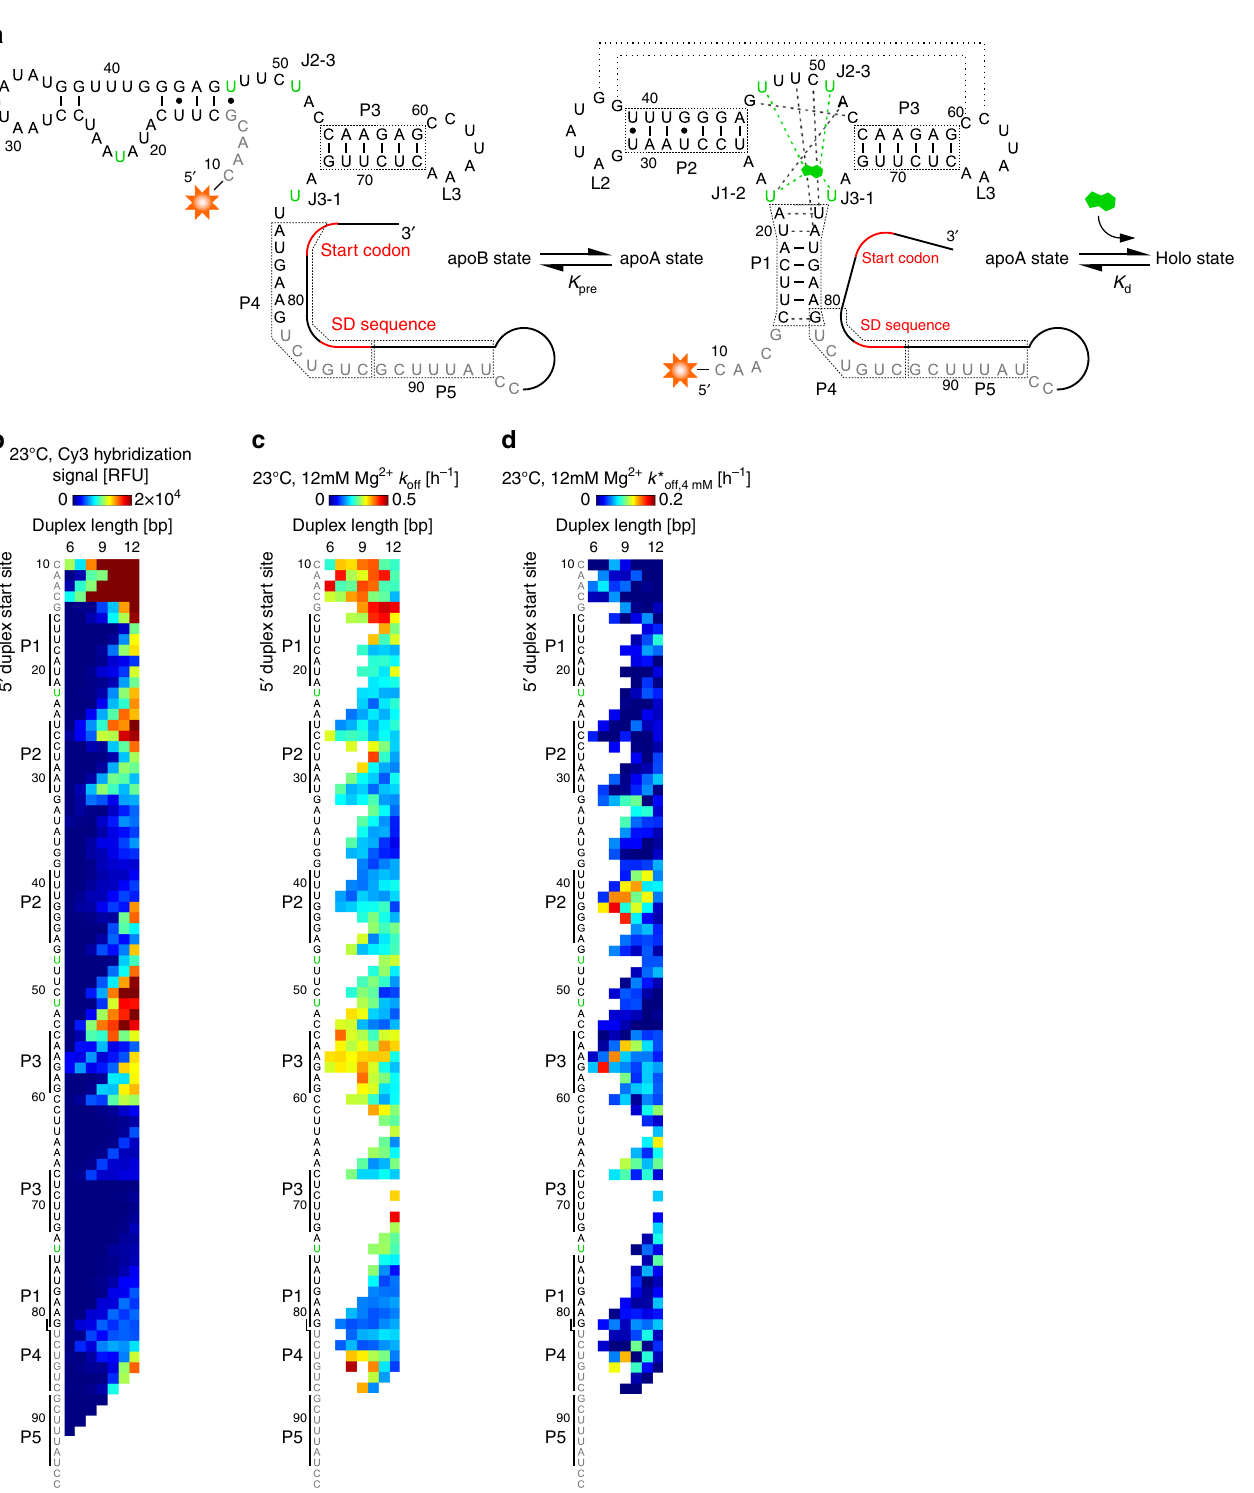
Fig. 6 ACE-Scan of the adenine-binding add riboswitch aptamer. a Secondary structure of the apoB (left) and apoA (right) states of the add riboswitch aptamer 46 . Stems (P1 – P5), loops (L2, L3) and junctions (J1 – 2, J2 – 3, and J3 – 1) are labeled. The location of adenine binding and other functional regions present in the holo structure are shown superimposed on the apoA state as follows: the kissing interaction between L2 and L3 (dotted lines), nucleotides known to interface with adenine (green bases and green dashed lines), and pairs of nucleotides known to interface in the holo state (black dashed lines). Riboswitch elements 3 ʹ of the aptamer involved in translational control were not synthesized here and are drawn schematically as black and red lines. Bases outside the consensus aptamer sequence are colored gray. b – d Heat maps showing the ( b ) hybridization landscape of add DAs at 23 °C, ( c ) k off landscape of add DAs at 23 °C under 12 mM Mg 2+ buffer-only conditions, and ( d ) k * off,4mM landscape of add DAs subject to 4 mM adenine, revealing induced fi